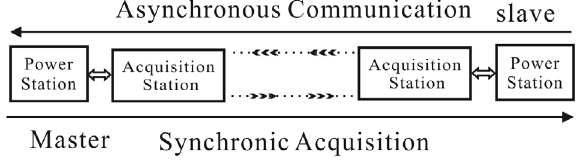
Figure 6. Schematic diagram of synchronous data-acquisition and asynchronous communication of the data-acquisition station.